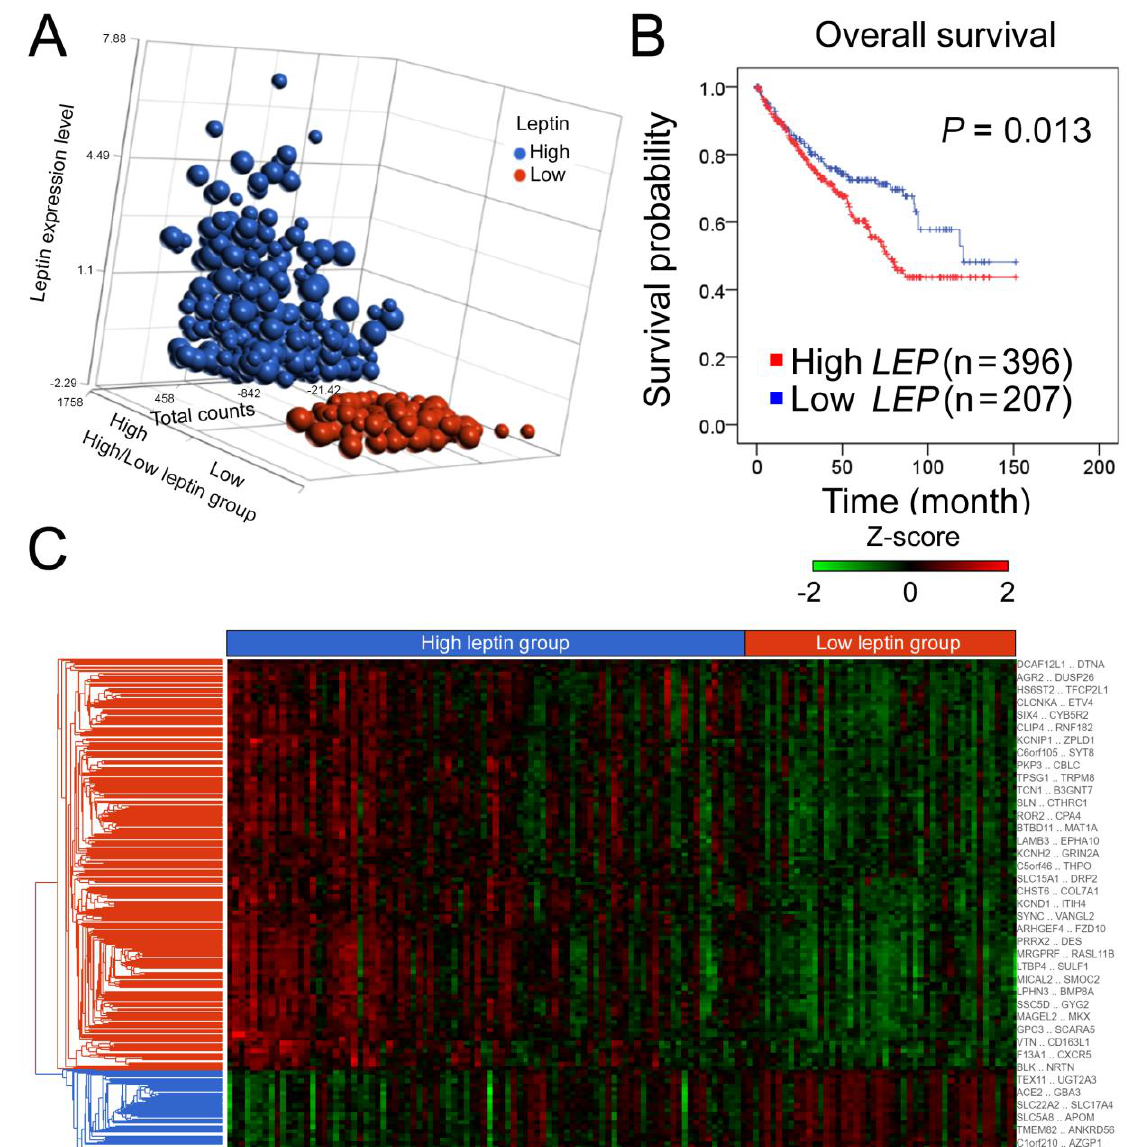
Figure 1. Correlation of leptin with clinical outcomes and hierarchical clustering of gene signatures based on leptin levels. The gene expression profile in the dataset of kidney renal clear cell carcinoma (KIRC) (dataset ID: Table 2. PANCAN) was determined by RNA-Seq platform (Illumina HiSeq). ( A ) Relative leptin and transcriptomic read counts (total counts) of clear cell renal cell carcinoma (ccRCC) patients in the leptin high/low groups; 603 cases were stratified to 396 cases in high-leptin group and 207 cases in low-leptin group. Size of dot indicates the relative case number of patients. ( B ) Kaplan–Meier analysis of leptin expression under the condition of overall survival probability in ccRCC patients. ( C ) Hierarchical clustering of genes in the high and low leptin groups. Z-scores were computed on a gene-by-gene basis by subtracting the mean and then dividing by the standard deviation.